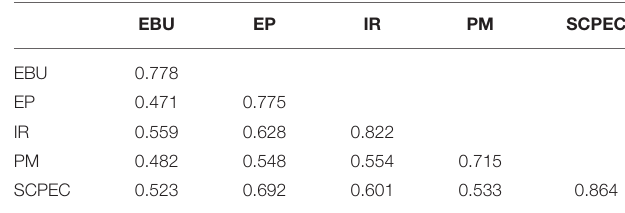
TABLE 2 | Fornell Larcker method.